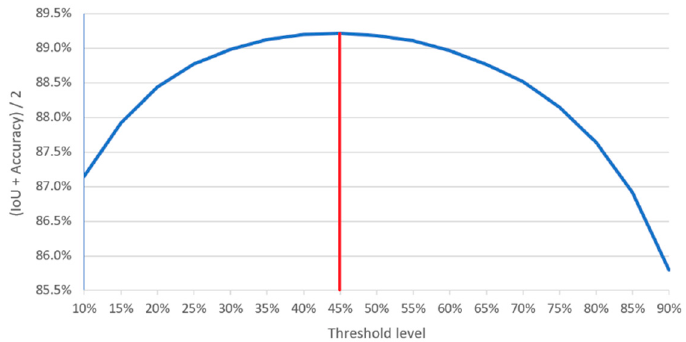
Figure 6. Threshold level evaluation for converting grayscale predictions to binary masks.